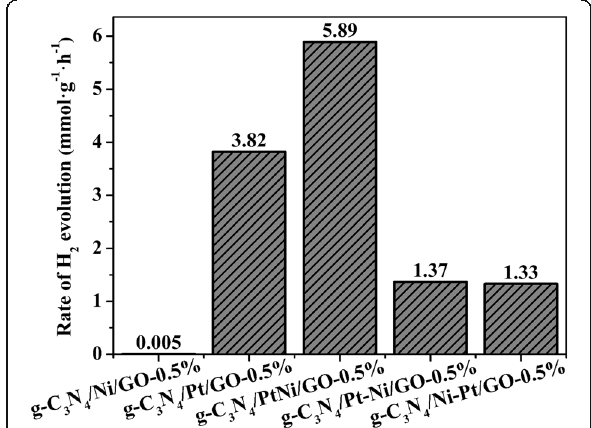
Fig. 4 H 2 evolution rate of series of g-C 3 N 4 /PtNi/GO-0.5% samples loaded with different type of cocatalyst. Light source: 300 W Xenon lamp ( λ > 420 nm). Reaction solution: 100 mL 20% ( v /v) TEOA aqueous solution (pH =